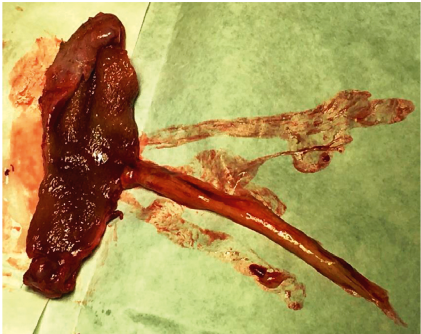
Figure 3: Gross specimen of the gallbladder with a mucus plug mimicking a worm.